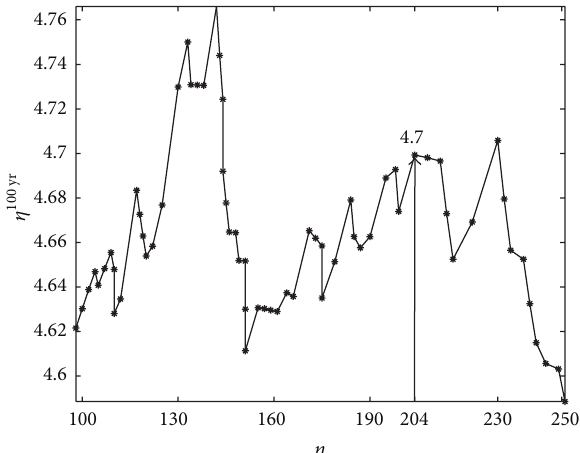
Figure 2: The point estimate ̃𝜂 100 yr of the 100-year return period value based on 20 years synthetic data as a function of the number 𝑛 of data points above threshold. The return level estimate = 4.7 at 𝑛 = 204 .